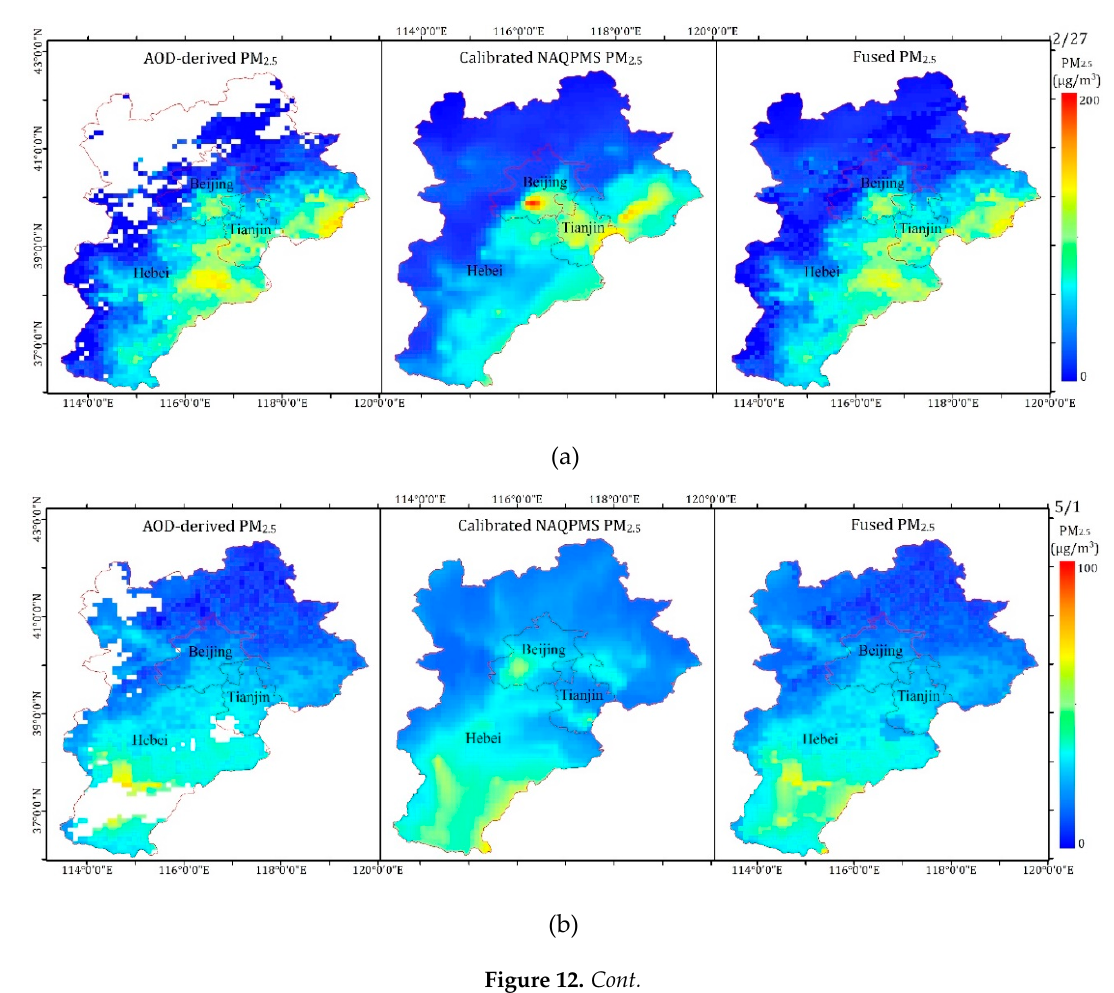
Figure 11. Assessment of seasonal LME model performance based on measured and estimated PM 2.5 concentrations for cross-validation ( a ) spring, ( b ) summer, ( c ) autumn, ( d )